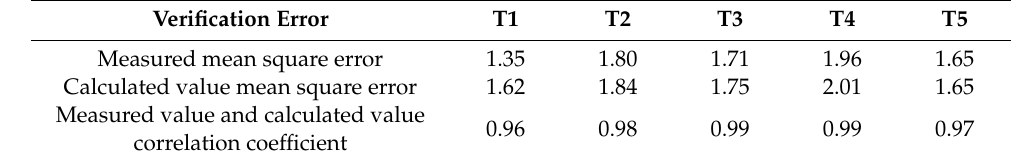
Table 2. Tide level verification error.